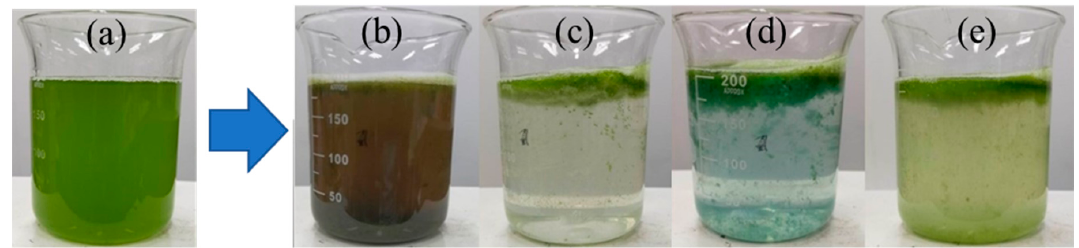
Figure 3. Appearance of suspensions before and immediately after treatment. ( a ) M. aeruginosa suspension before treatment. Suspensions after treatment using ( b ) Fe anode, ( c ) Al anode, ( d ) Cu anode, and ( e ) Zn anode.